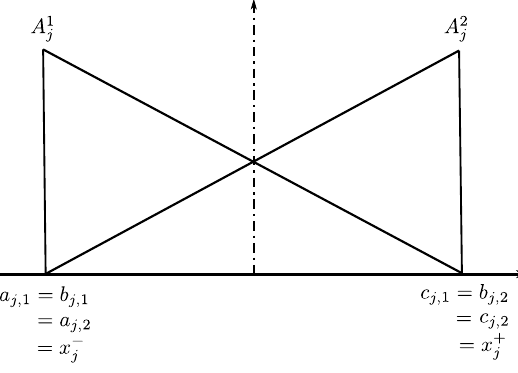
Figure 2. Initial membership functions for x j .